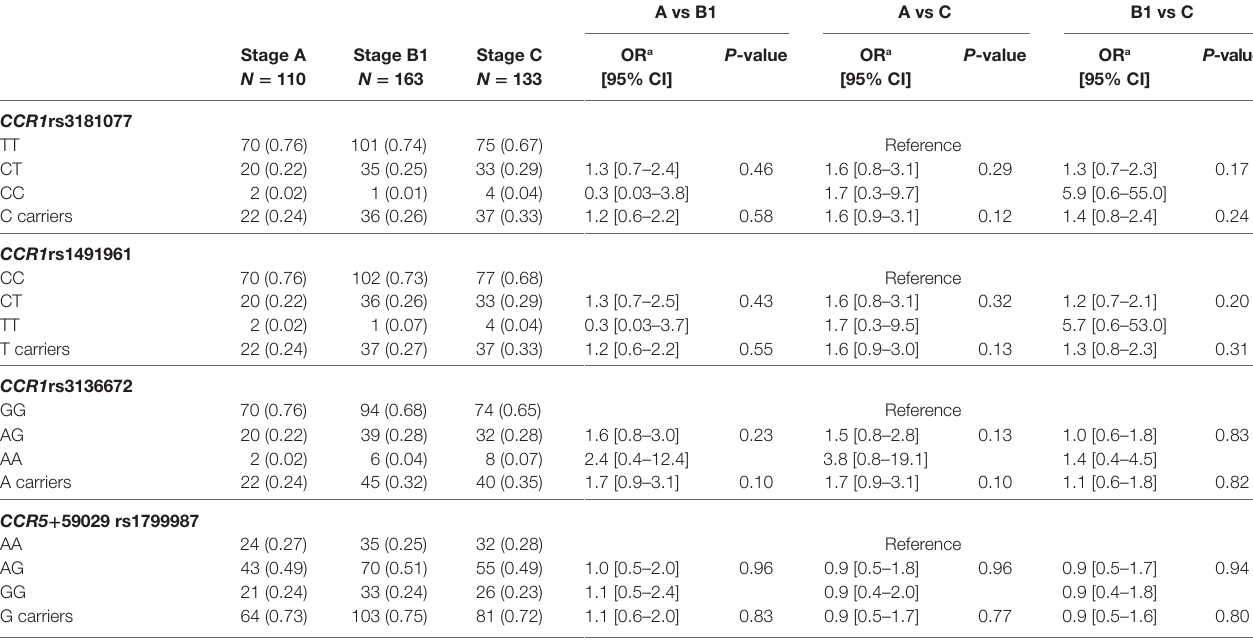
a Odds ratio (OR) values shown are corrected for gender and ethnicity. Results are shown as n (frequency). CI, confidence interval. Total genotype counts can vary due to different genotypic call rates.